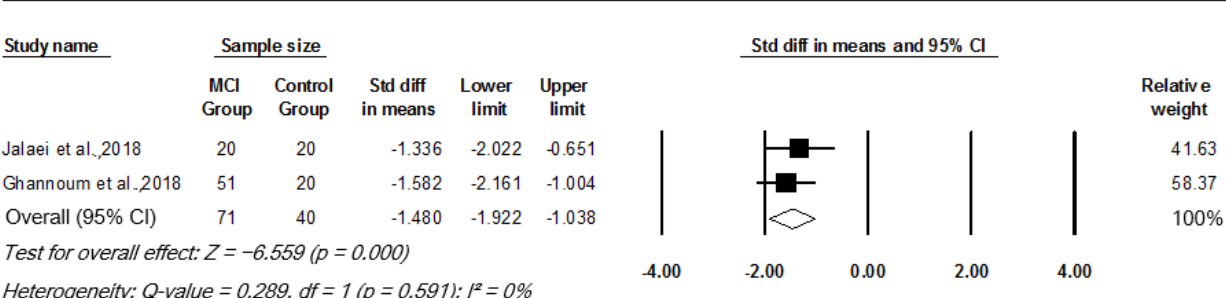
Figure 6. Forest plot of standard mean difference and overall (pooled) estimate of studies investigat- ing speech perception in noise (SPIN) test that compared a mild cognitive impairment (MCI) group to a control group. Notes: Z = Z score; I 2 = percentage of heterogeneity; Q-value = Cochrane’s Q; df = degrees of freedom. The horizontal lines represent the 95% confidence interval (CI) for each computed standard mean difference. Weights are from the random-effects analysis.